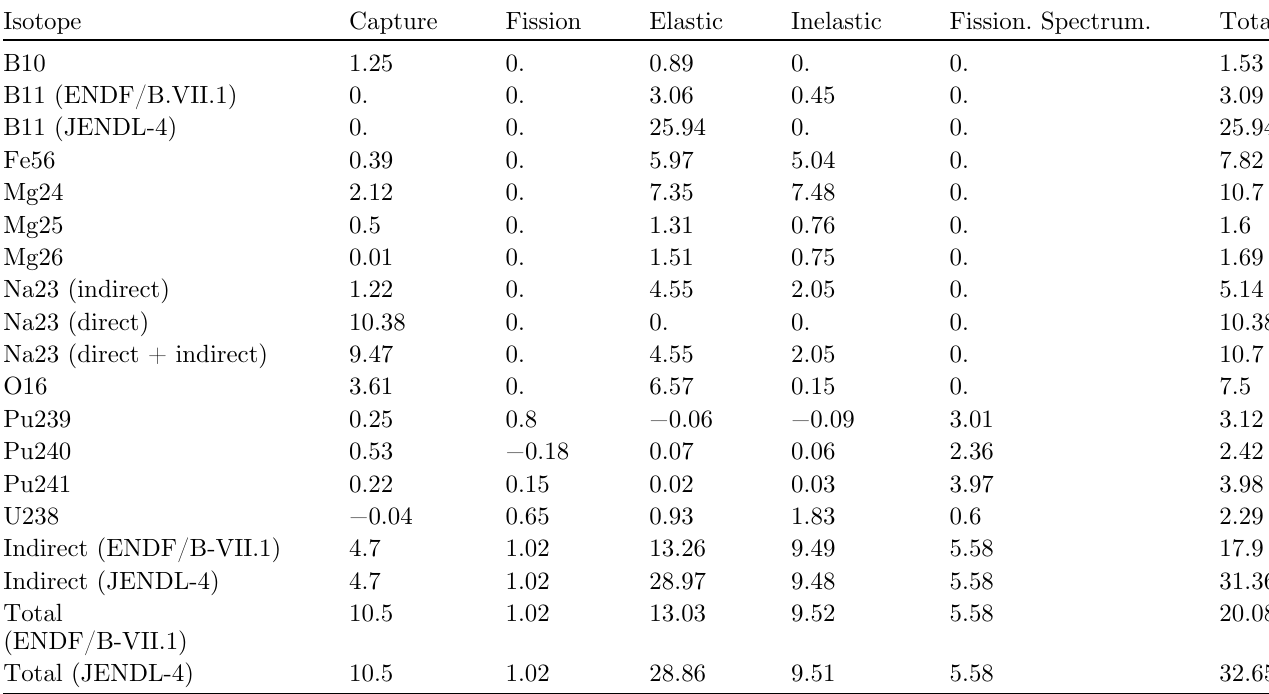
Table 6. Uncertainties (in %) due to nuclear data on the activation of secondary sodium. Isotope Capture Fission Elastic Inelastic Fission. Spectrum. Total 1.25